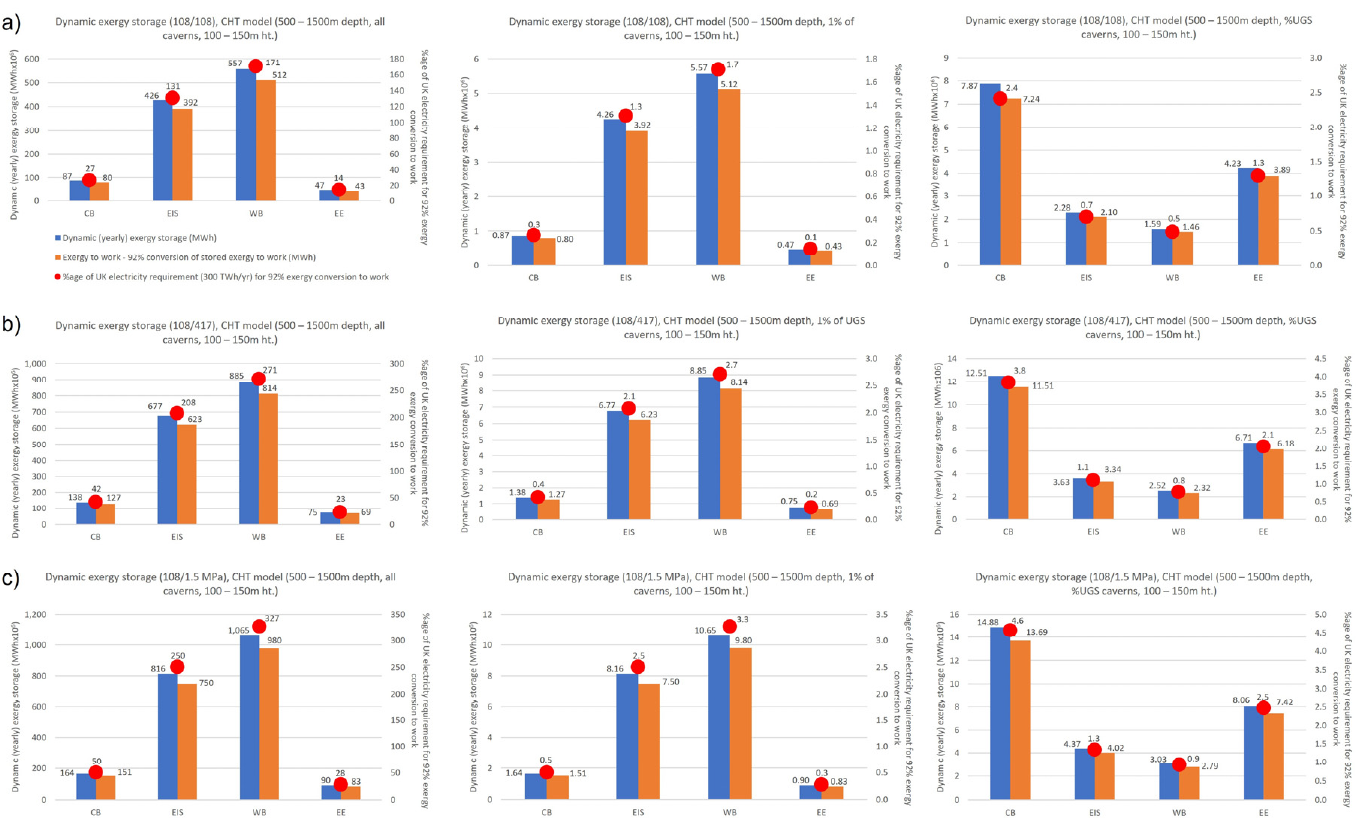
Figure 8. Plots of dynamic exergy storage and exergy to work estimates for the preferred CHT model, over the depth range 500–1500 m and cavern heights 100–150 m considered for CAES. Parts ( a – c ) show graphs for differing injection/withdrawal rates (108/108 kg/s and 108/417 kg/s) or fill and pressure reduction rates (108 kg/s/1.5 MPa/h) for all potentially available caverns, 1% of available caverns and estimates based upon the number of UGS caverns in the basins. Additionally shown, by basin, the percentage of UK electricity demand for 92% of stored exergy to work. Key common to all, see Figure